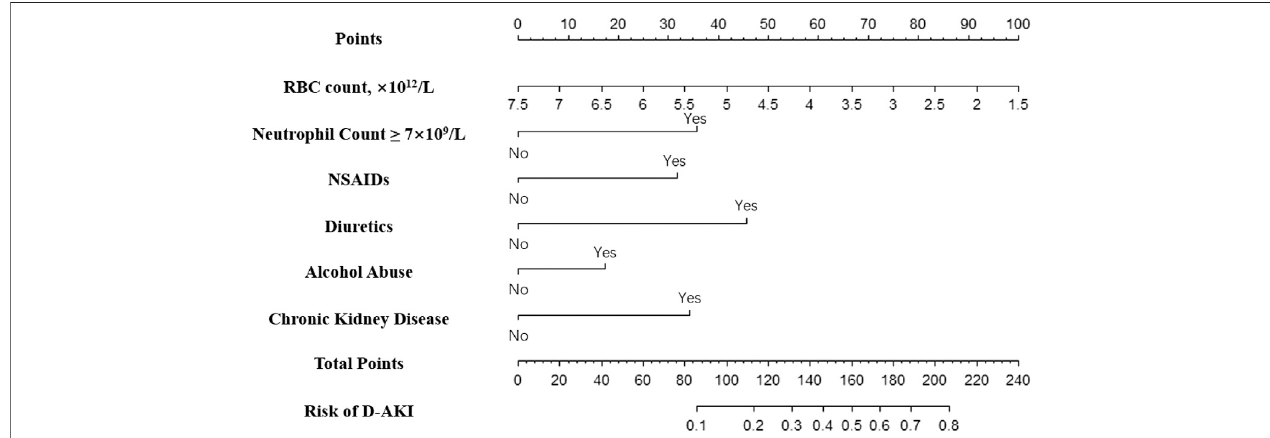
FIGURE 2 | Nomogram for the prediction of D-AKI.